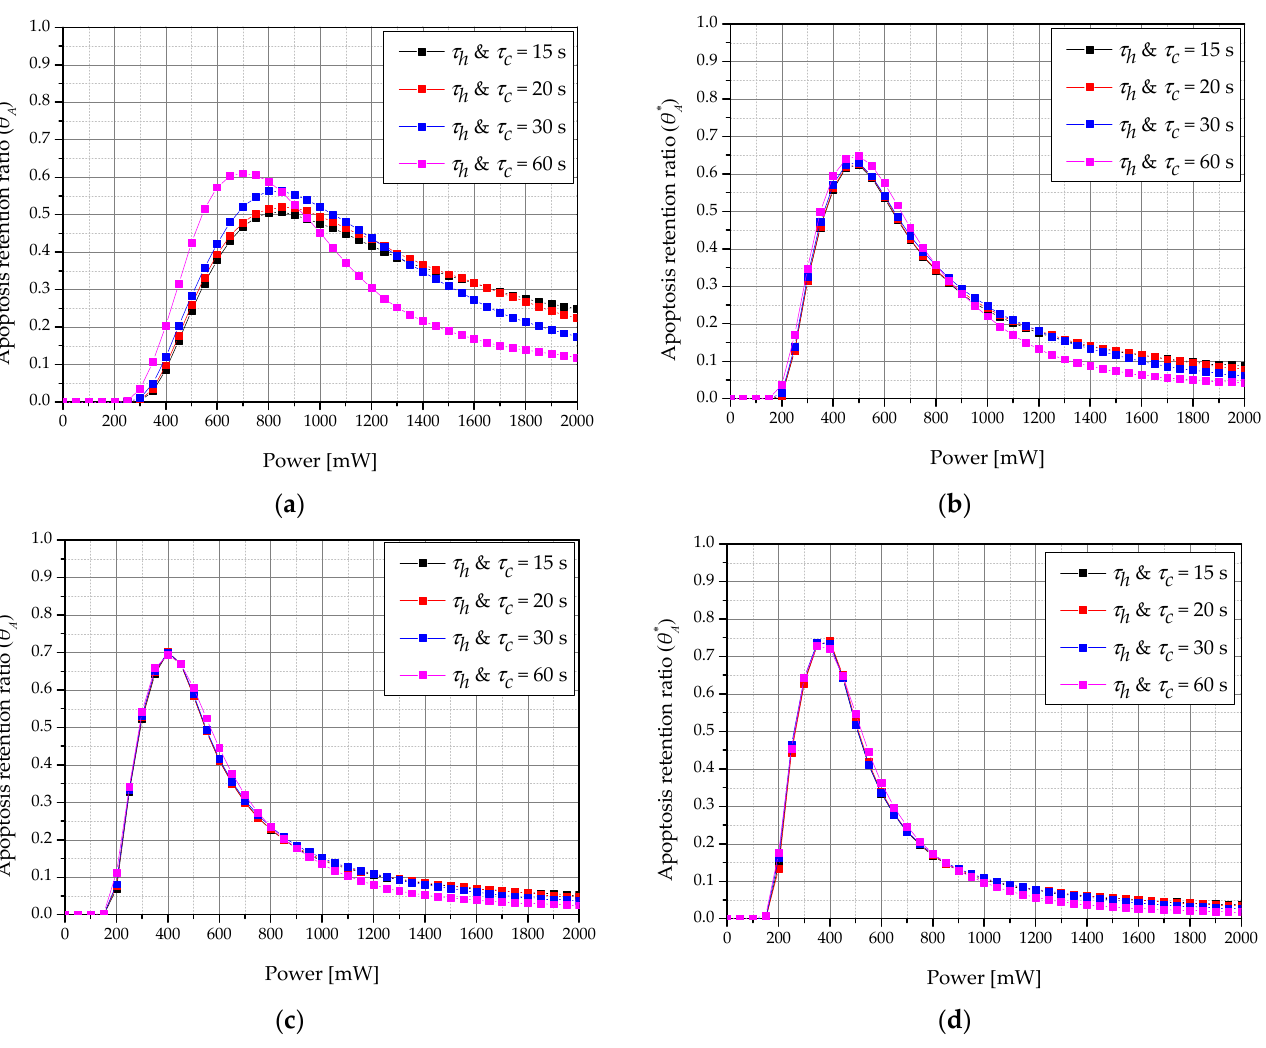
Figure 10. Apoptosis retention ratio ( 𝜽 𝑨∗ ) for various heating/cooling time ( τ h & τ c ) ( f v = 10 − 6 ) ( a ) τ tot = 120 s; ( b ) τ tot = 360 s; ( c ) τ tot = 600 s; ( d ) τ tot = 840 s.